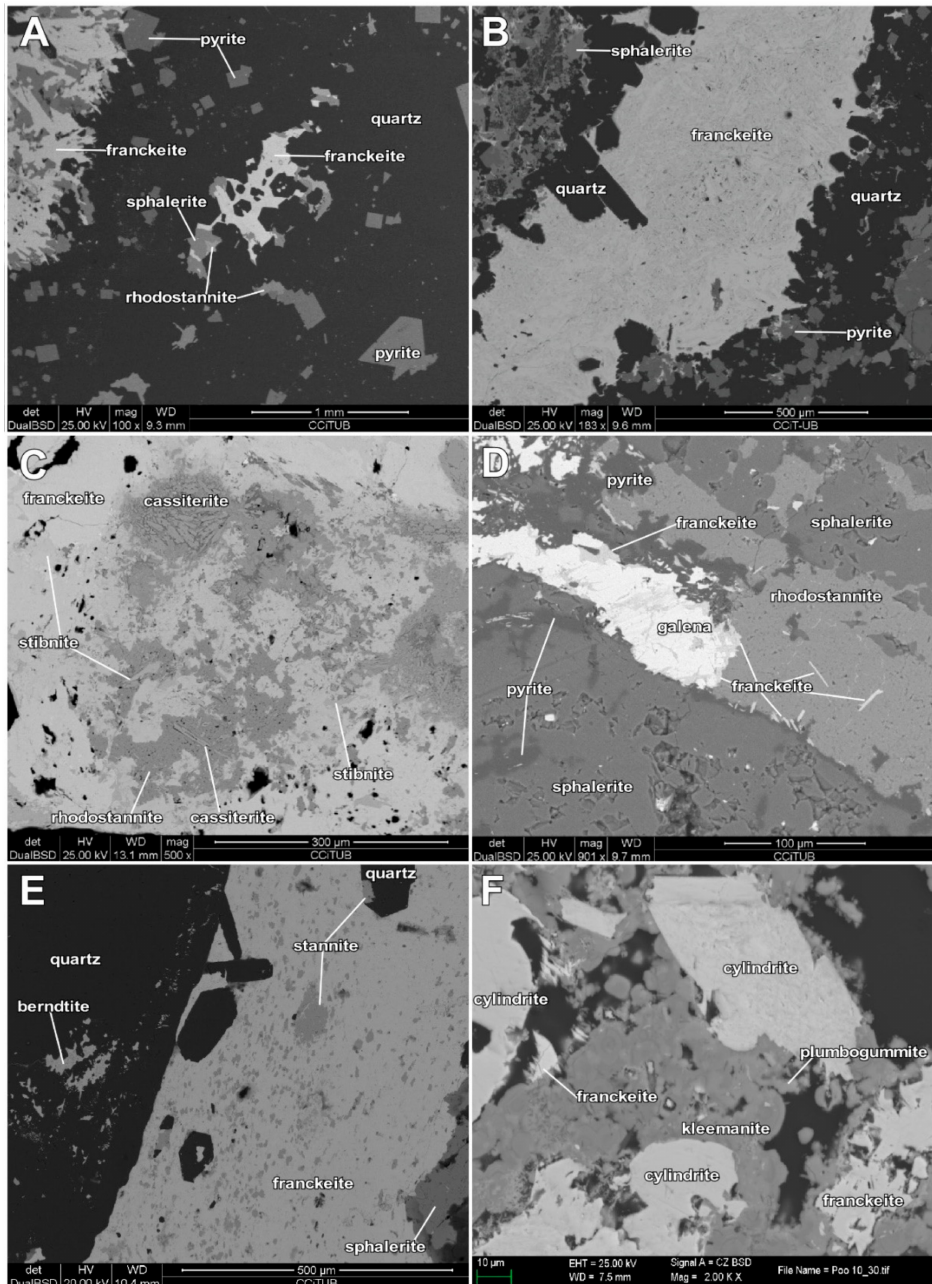
Figure 7. Back-scattered electron images of ore associations that are rich in tin minerals at the Poop ó deposit. ( A , B ) Micro-cavities or geodes dominantly lined by franckeite; notice that sphalerite in B occurs earlier in the paragenetic sequence than in A. ( C ) Franckeite replaced by an assemblage of rhodostannite, cassiterite and stibnite. ( D ) Sphalerite replaced by pyrite and galena, and then by rhodostannite and franckeite. ( E ) Micro-cavities in quartz lined by bendtite, and banded mineralisation with mutual intergrowths of quartz, franckeite and stannite. ( F ) Cylindrite and franckeite followed by supergene kleemanite and